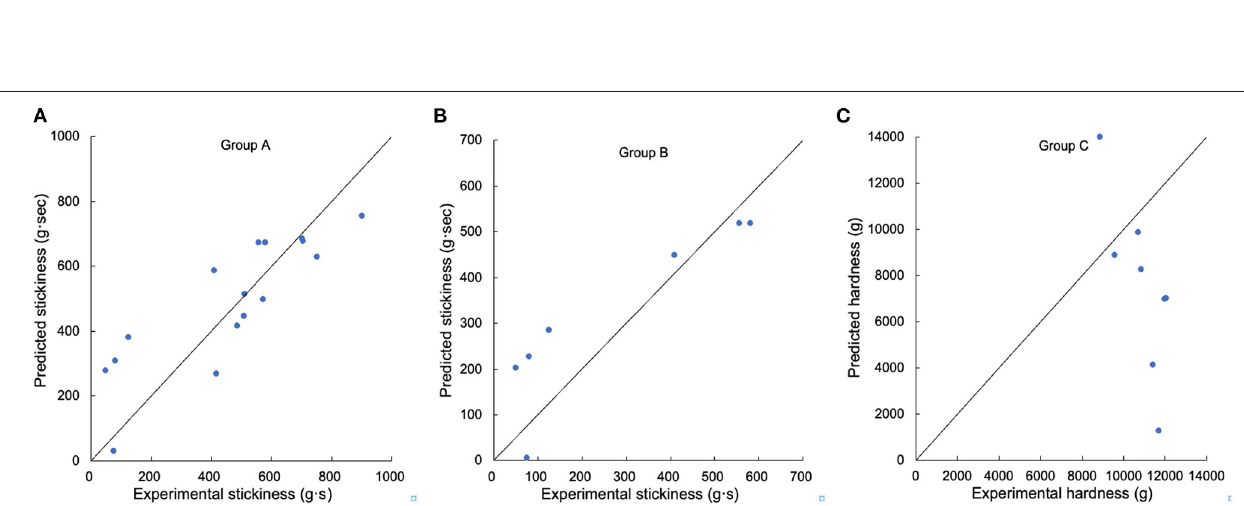
Frontiers in Nutrition |